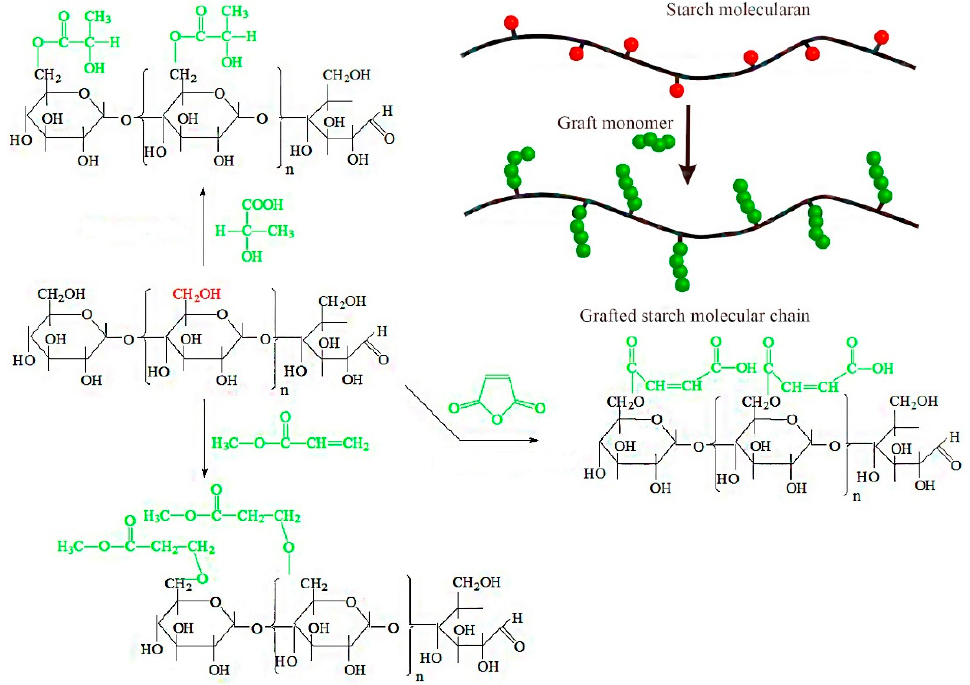
Figure 1. In situ solid phase polymerization of corn starch and hydrophobic groups.